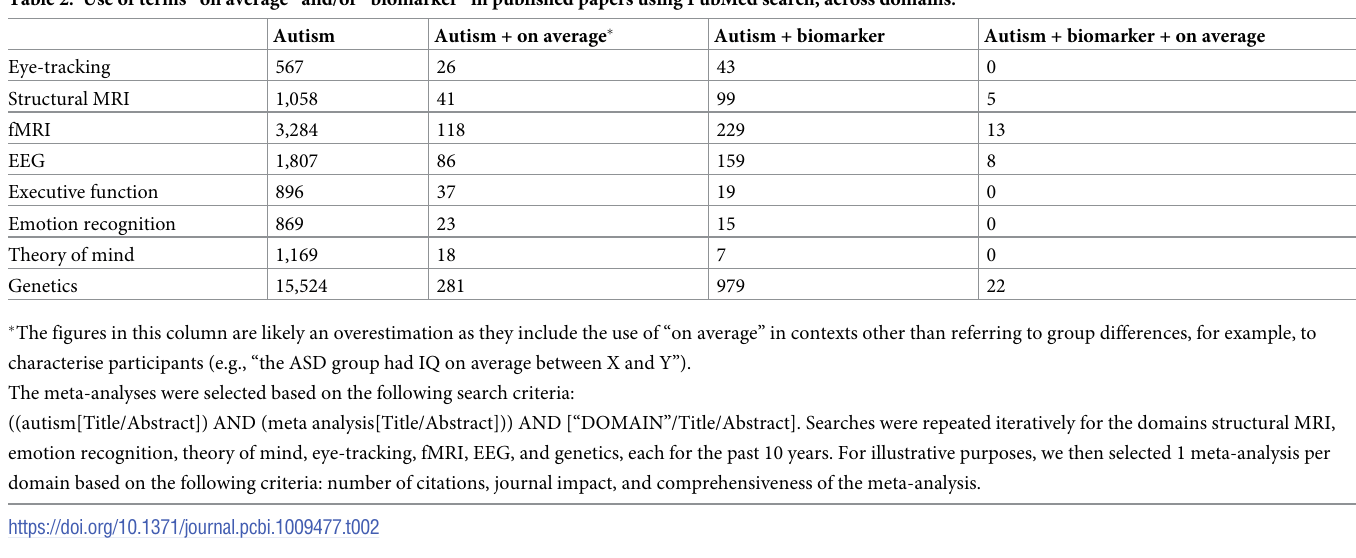
Fig 3. Average effect sizes of meta-analyses per modality. The distributions of the original data included in the meta-analyses were often not reported. This is exemplified in S1 Table where we checked information on the data distributions of the 49 original papers included in a review of emotion recognition [20]. However, in the majority of papers, parametric statistics were employed, which may be taken as indicating normal distribution. EF, executive function; ET, eye- tracking; fMRI, functional MRI; MMN, mismatch negativity; PRS, polygenic risk score; ROI, region of interest; sMRI, structural MRI; SNP, single-nucleotide polymorphism; ToM, theory of mind.